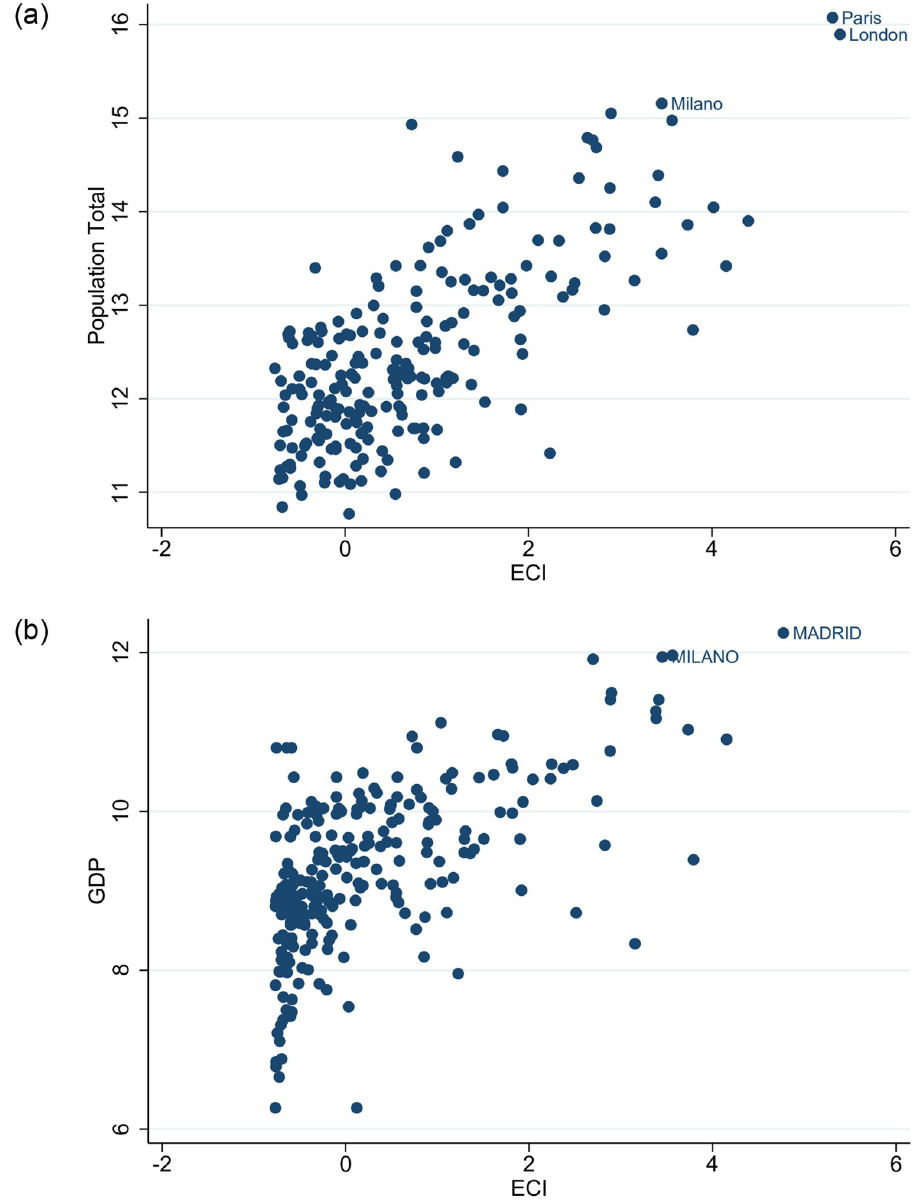
Fig 9. Cities economic complexity (ECI), population and development. [a] ECI vs Population; [b] ECI vs GDP. The figures have been generated using StataSE